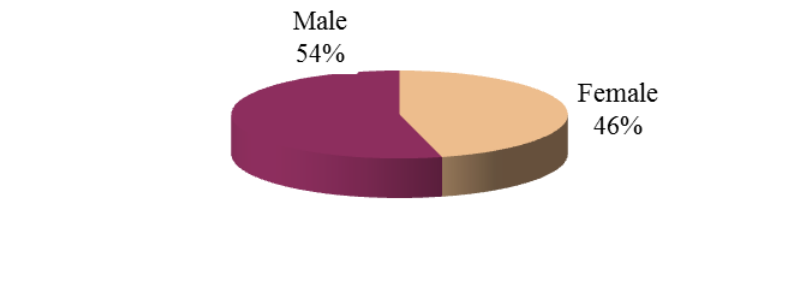
Figure 5. Teachers’ gender.